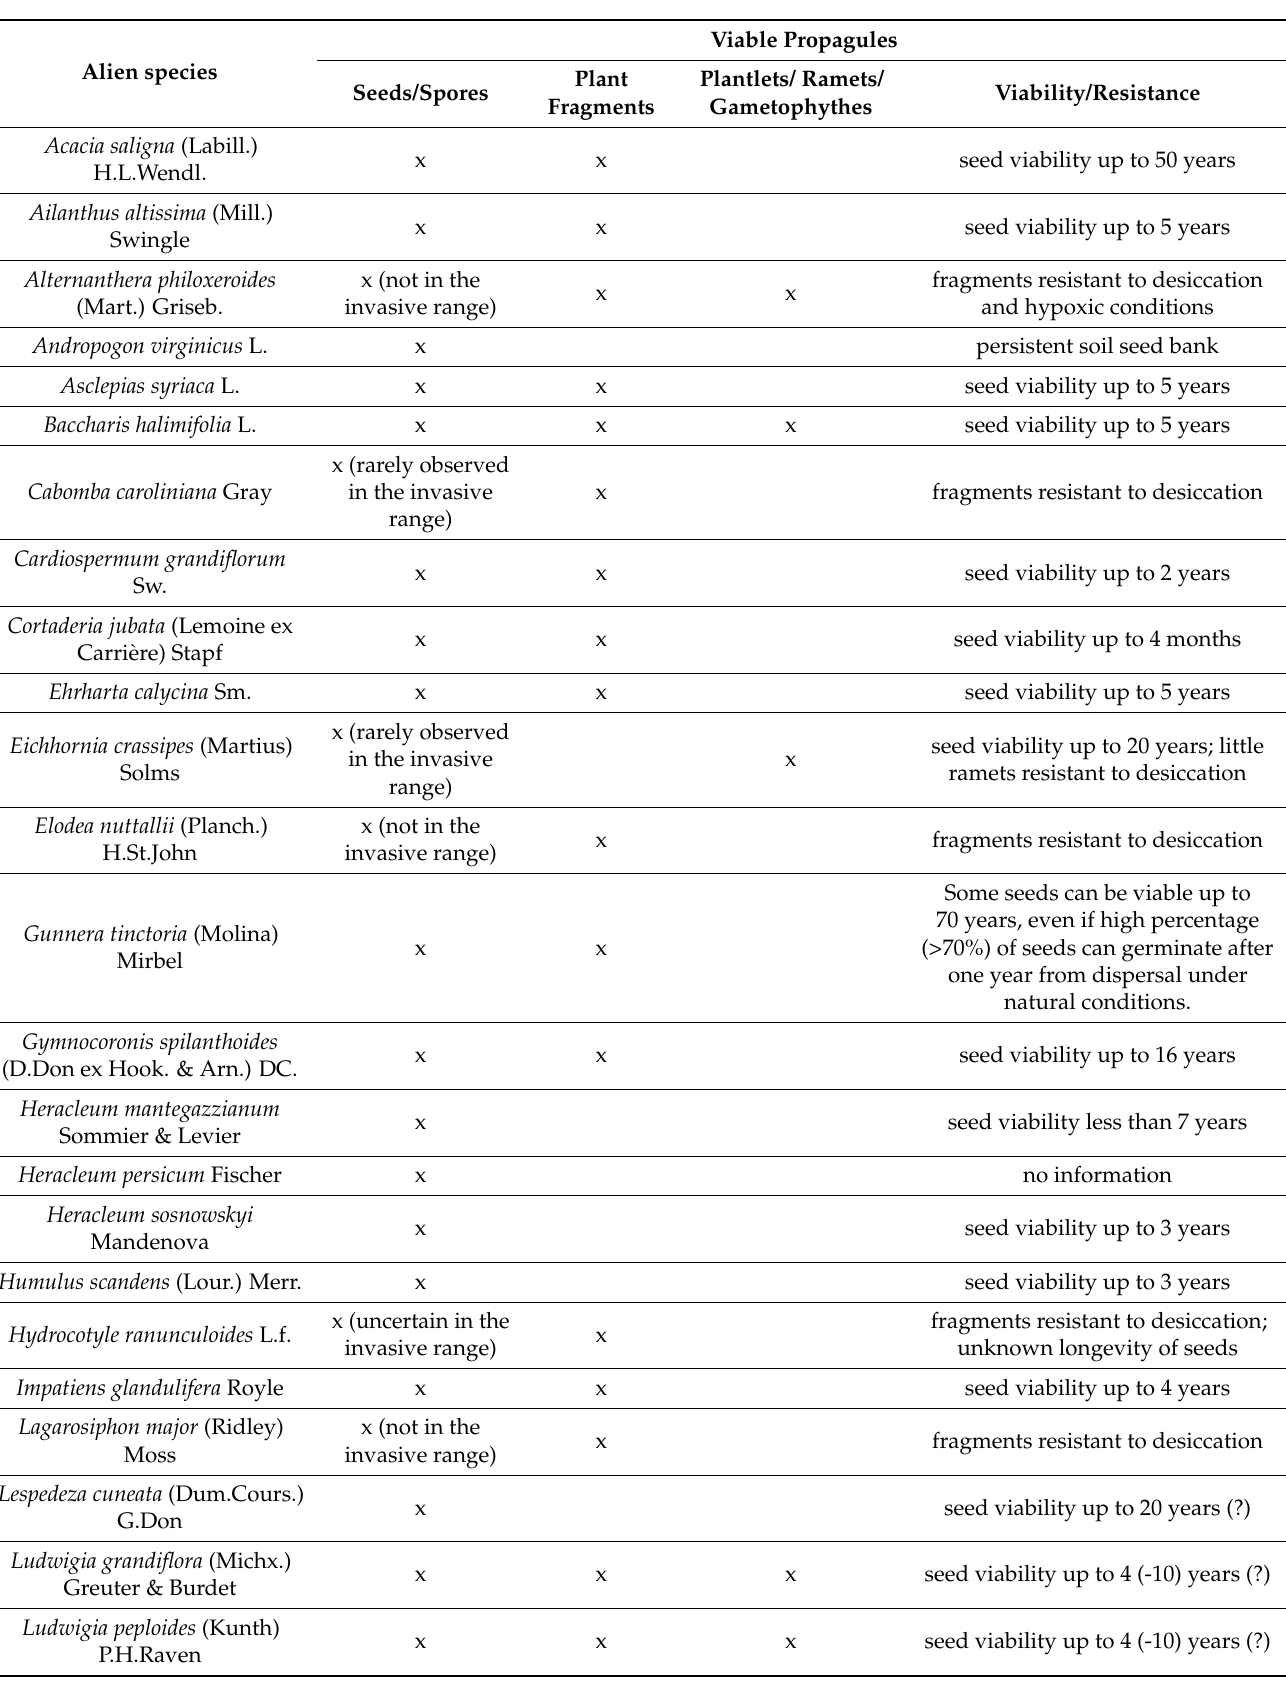
Table 5. IAPUC viable propagules likely to be accidentally transported along spread pathways (and natural